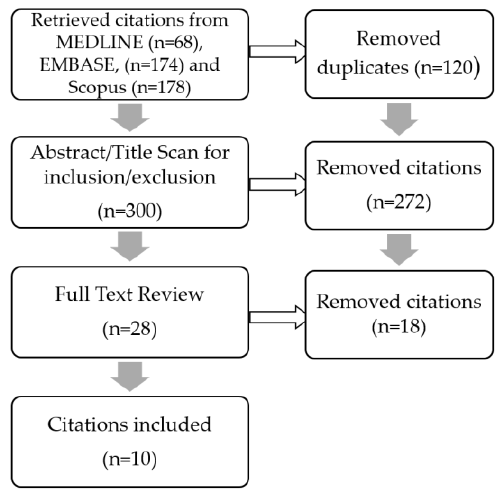
Figure 1. Scoping review article selection process.